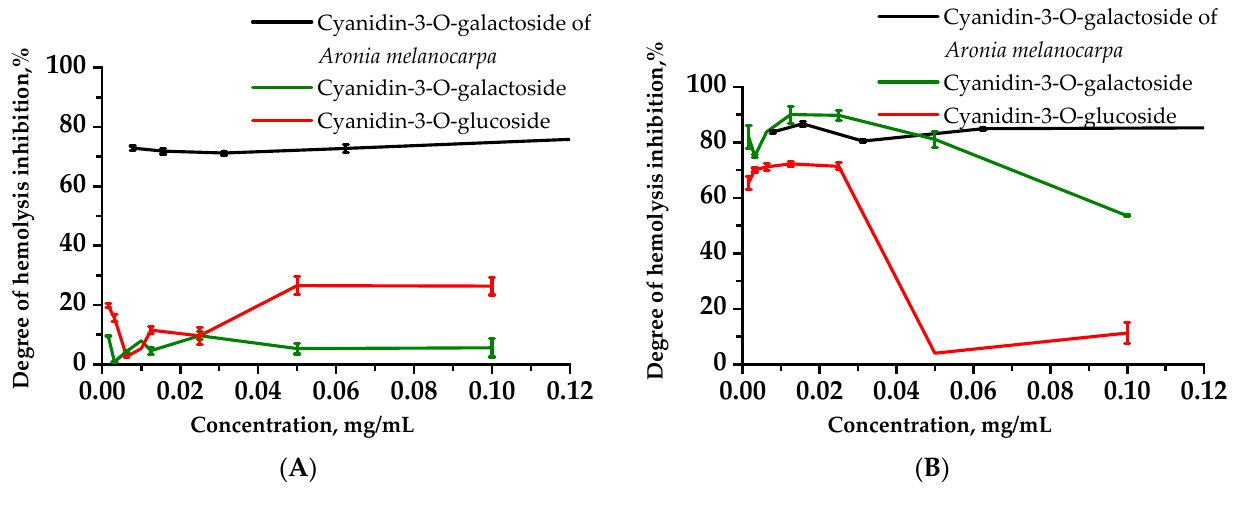
Figure 2. Osmotic ( A ) and peroxide ( B ) red blood cell hemolysis intensity vs. the concentration of cyanidin-3-O-galactoside Aronia extract, cyanidin-3-O-galactoside and cyanidin-3-O-glucoside using the model system of osmotic red blood cell damage and oxidative damage caused by Fenton reagent. Values are expressed as percent inhibition (mean ± S.D.).